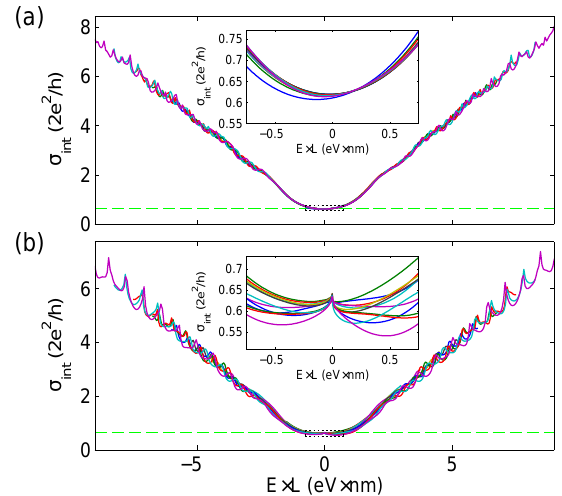
Figure 7. Intrinsic conductivity as a function of E L for ( a ) aGNRs and ( b ) zGNRs × with W = 150 nm and L [5 , 60] nm. The dashed horizontal lines indicate the universal ∈ value σ = 4 e 2 /π . The insets show an enlargement of the regions around the minimum 0 conductivity indicated by dotted rectangles in the main